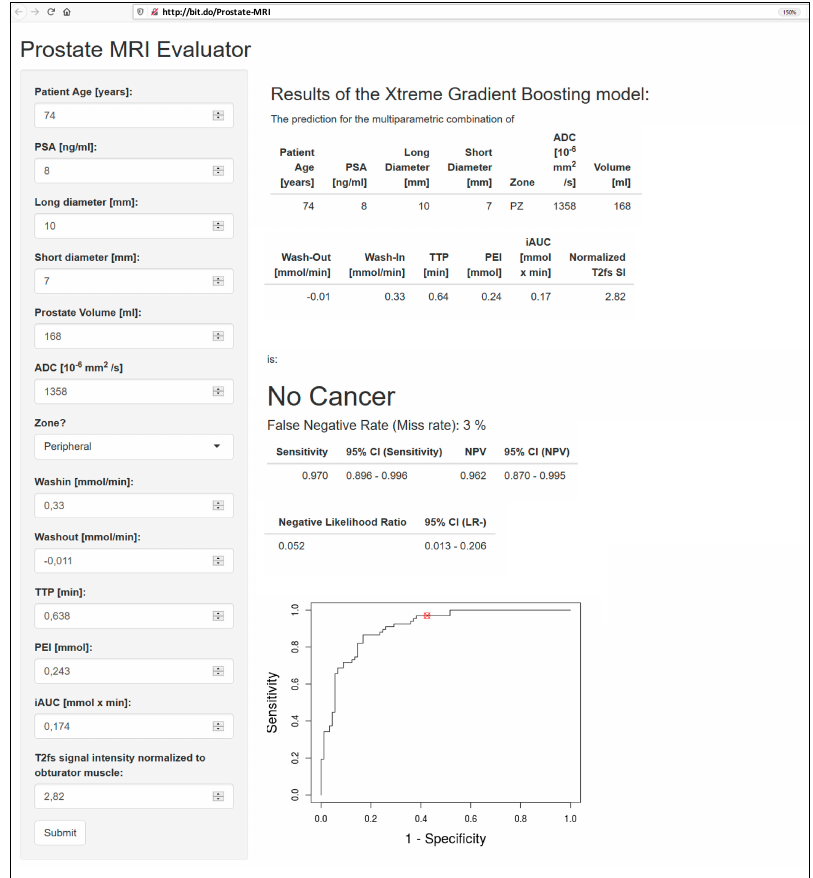
Figure 5. Interface of the open-access web application, accessible at http://bit.do/Prostate-MRI, with an analysis of the peripheral zone PI-RADS 4 lesion presented in Figure 4. The lesion was correctly classified as benign, with an error rate of 3%. Its location on the ROC curve is highlighted with a red circle. Sensitivity: 97.0% (95% CI: 89.6–99.6%); NPV: 96.2% (95% CI: 87.0–99.5%); negative likelihood ratio: 0.052 (95% CI: 0.013–0.206).